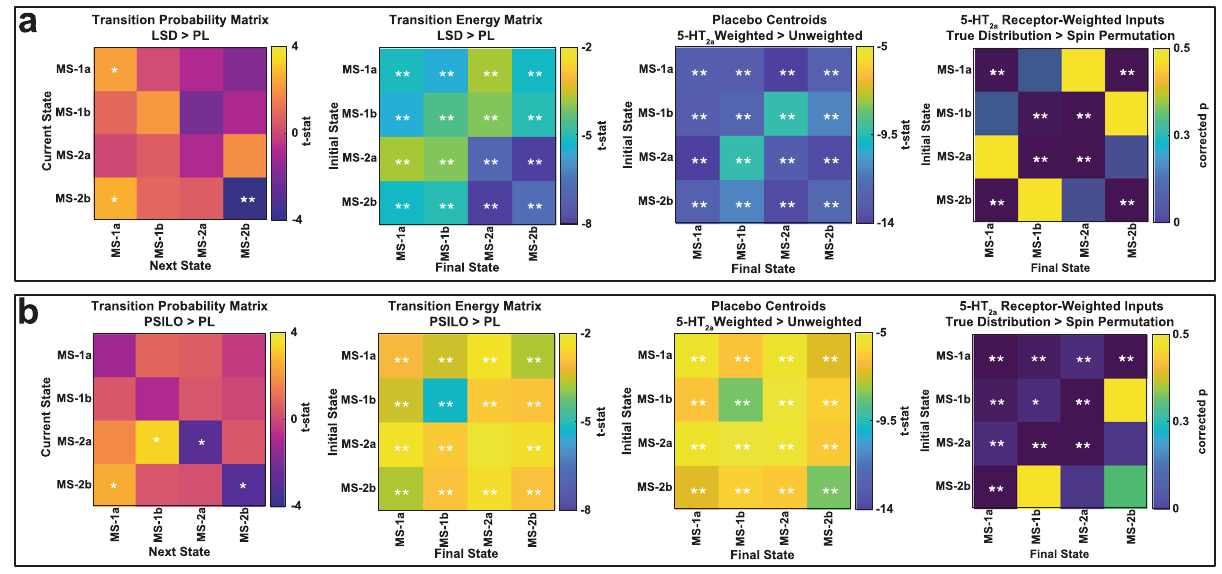
Fig.4|Thecontrolenergyneededtotransitionbetweenbrainstatesisreduced by LSD, psilocybinand thespatialdistributionof5-HT2areceptormaps. a LSD comparisons ( n =15) ( b ) Psilocybin comparisons ( n =9). ( a , b , left) Comparison of the empirically observed transition probabilities between states, derived from the brainstatetimeseries,e.g.Figure3a.( a , b ,centerleft)Comparisonofthetransition energies calculated from placebo brain states versus those calculated from LSD or psilocybin brain states using uniformly-weighted whole-brain inputs. LSD and psi- locybin brain states both had signi fi cantly lower energy required for every transi- tion. ( a , b , center right) Weighting the control vector by the 5-HT2a receptor densitymap 35 resultsinsigni fi cantlylowerenergiesfortheplacebocentroids(brain states) compared to uniformly-weighted control vector inputs. ( a , b , right) To